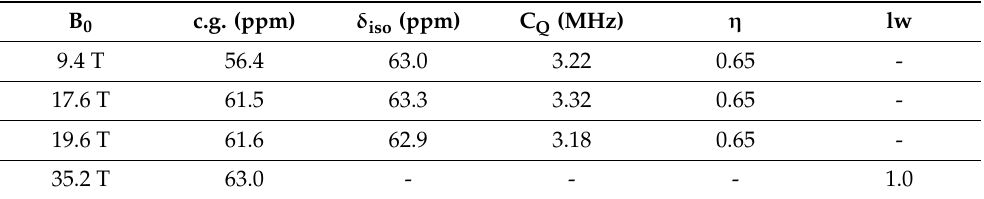
Table 13. NMR parameters from the simulation of the 27 Al spectra of specimen CLBR at four external magnetic fields (B 0